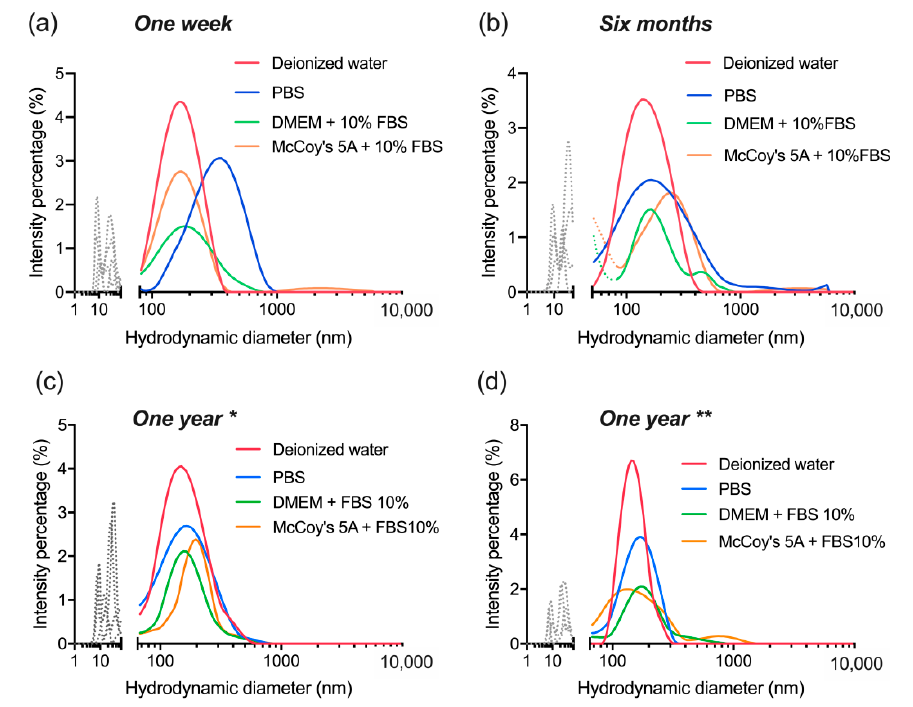
Figure 10. Evaluation of colloidal stability of lyophilized dBSA-UCNP-NOBF 4 in different buffers at all three checkpoints based on the average results of three repeated size measurements by DLS: ( a ) after one week of lyophilization; ( b ) after six months; ( c , d ) after one year. * before ultrasonication, ** after ultrasonication; gray and/or dotted lines below 100 nm correspond to the presence of proteins and protein aggregates.